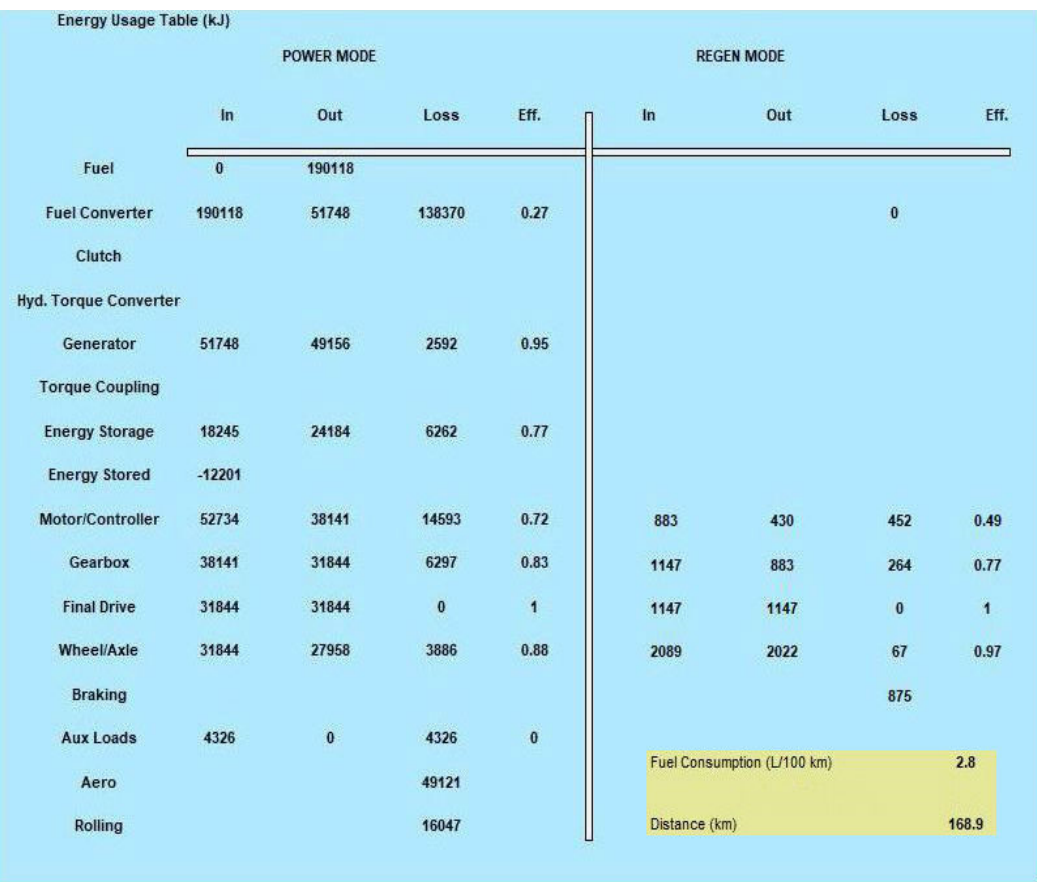
Figure 8. Speed profile (up), SOC history (center) and time interval in which the MGT works (down) in the extra-urban cycle. Energies 2020 , 13 , x FOR PEER REVIEW